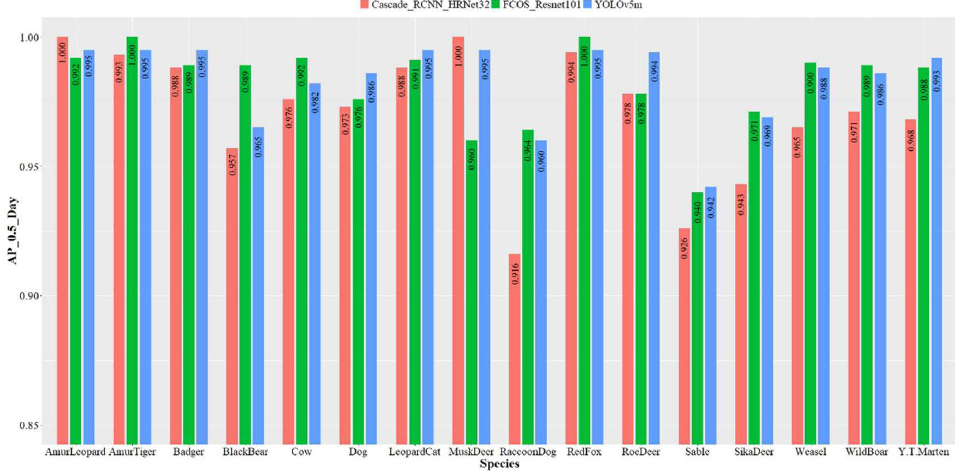
Figure 5. Recognition accuracy of each species of three object detection models based on the daytime dataset. The y -axis is the AP value when IOU = 0.5, ranging from 0.85–1; the x -axis is the species.